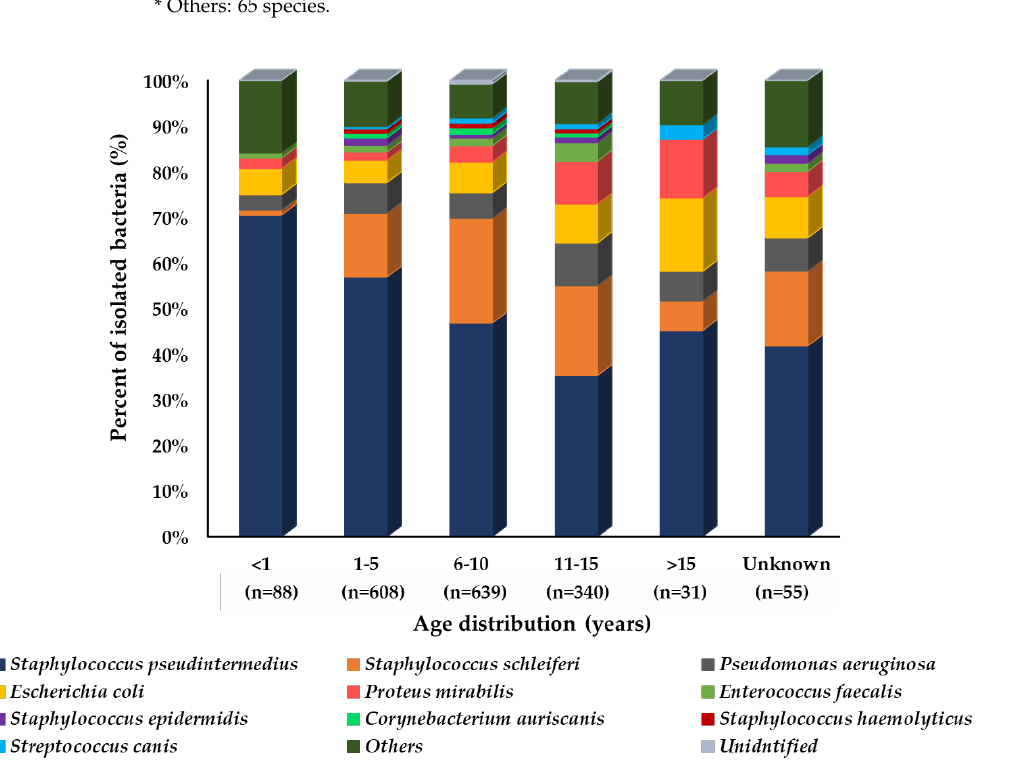
Figure 3. Prevalence of isolated bacteria (%) from dogs’ skin specimens by age group ( n = 1761). In the graph, “ n ” represents the number of recovered